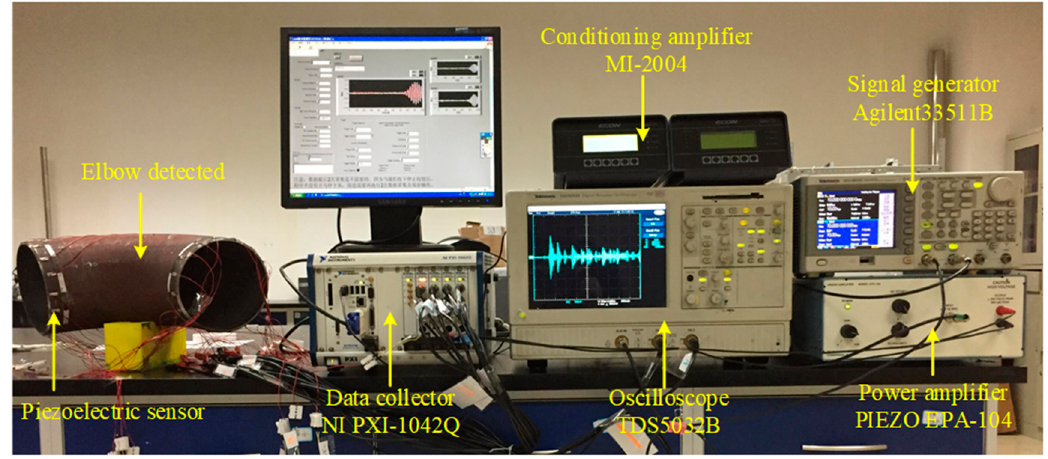
Figure 9. Ultrasonic guided wave detection experimental platform.